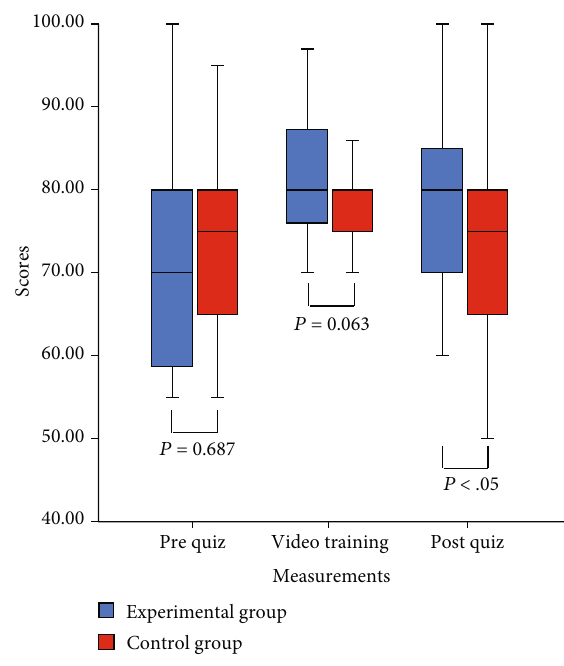
Figure 2: Boxplots of the prequiz scores, video training scores, and postquiz scores for the experimental and control